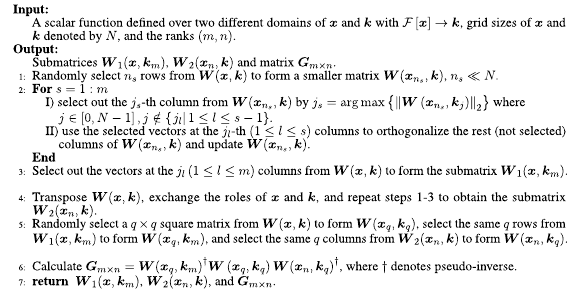
Algorithm 1. Low-rank decomposition of a mixed-domain